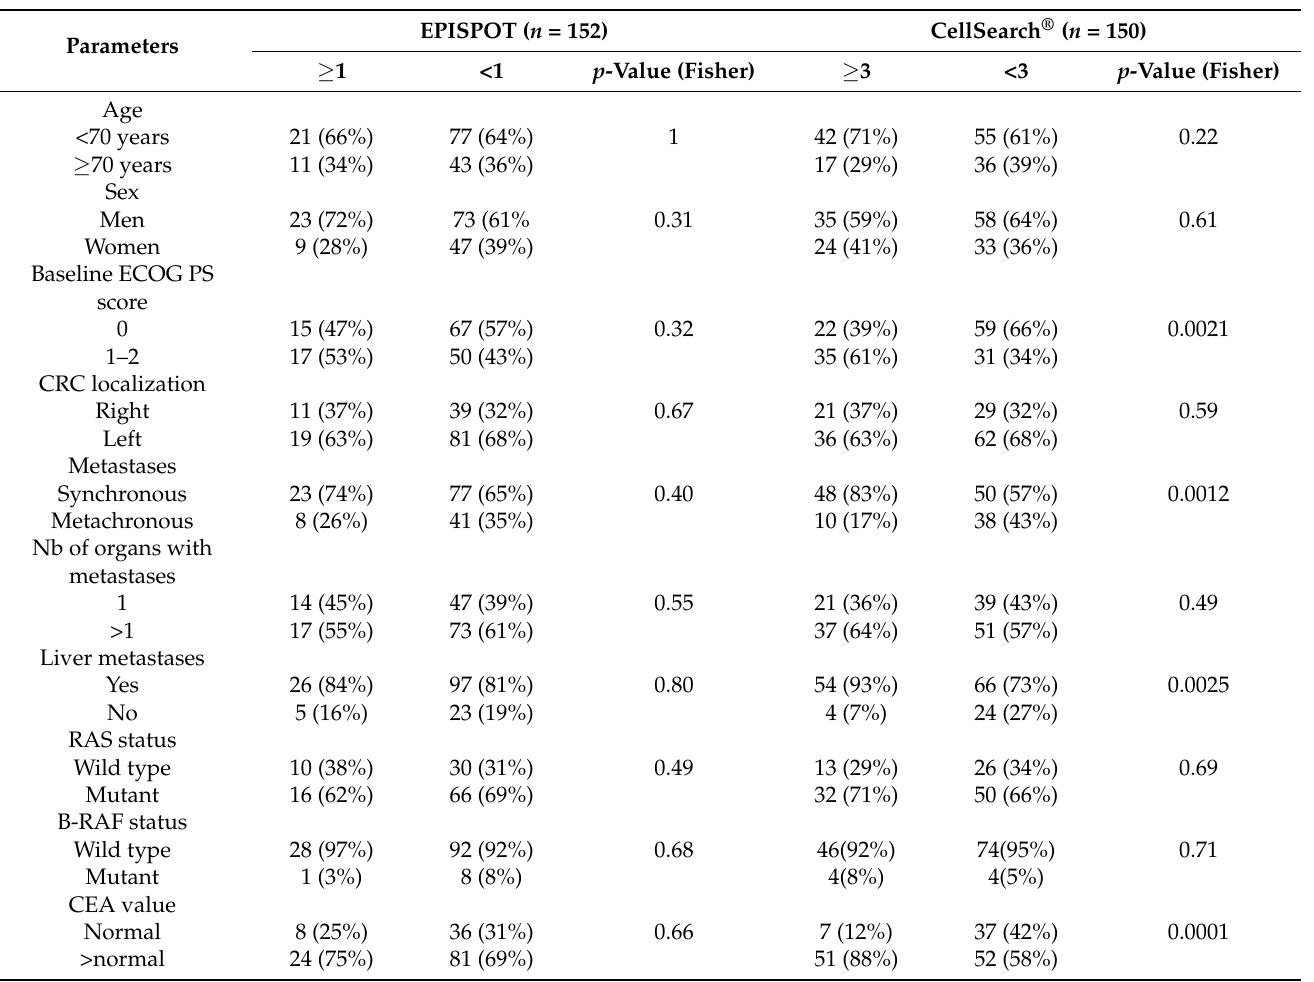
Table 1. Patient characteristics and correlation with CTC number. CTCs were detected with two methods: CK19-EPISPOT and CellSearch ®